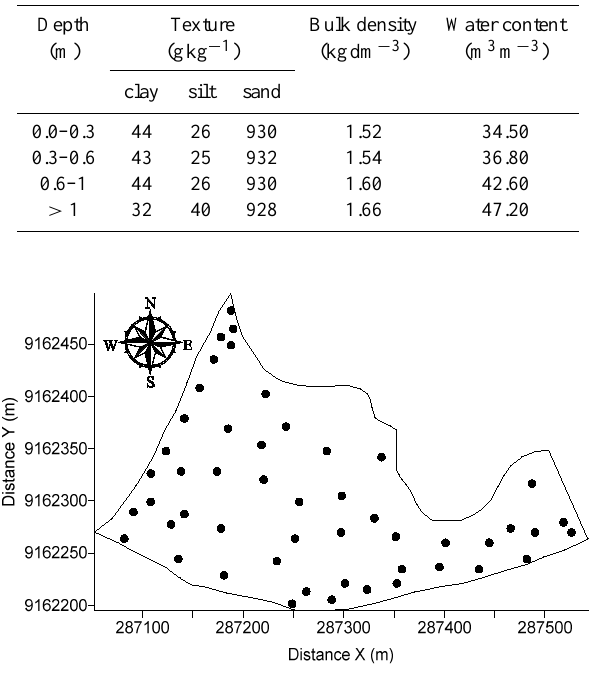
Fig. 1b. Sampling scheme for penetration resistance